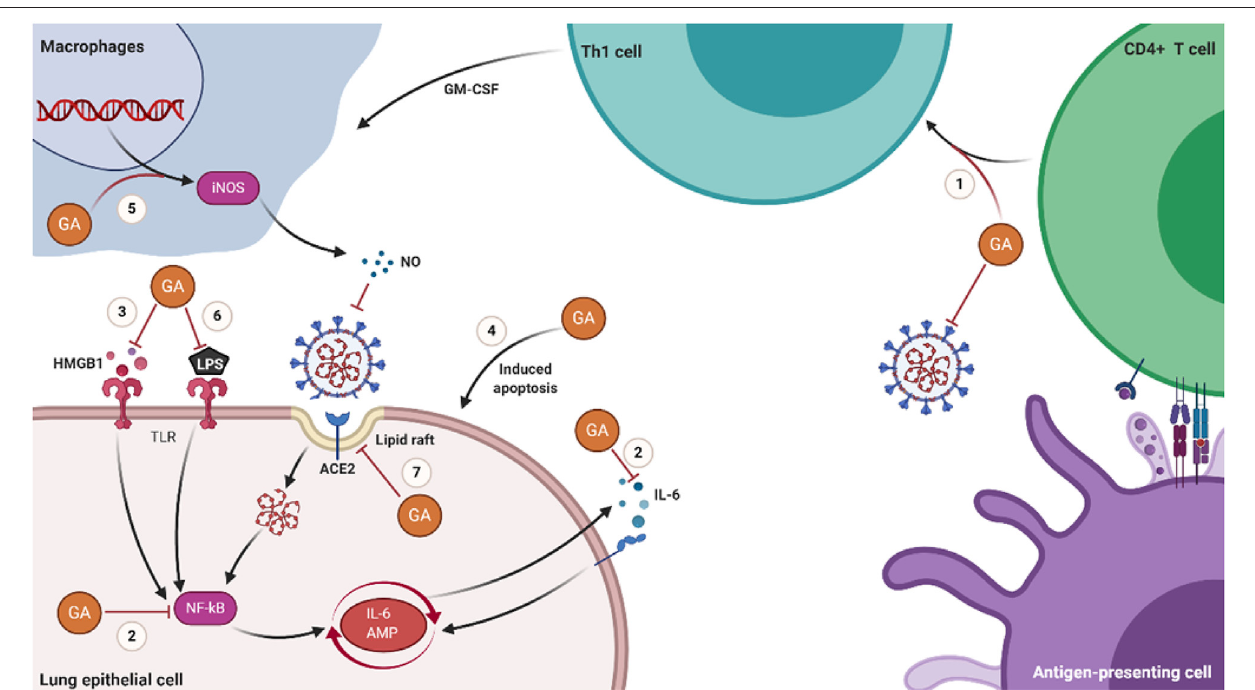
FIGURE 2 | Schematic diagram of the molecular mechanisms of GA in treating COVID-19. (1) GA promotes the proliferation of T cells and has Th1 cell immune adjuvantactivity. (2)GAinhibitsthe production ofIL-6and theactivationofNF- κ B. (3)GAinhibits theactivity ofHMGB1and thesignal transduction oftheHMGB1-TLR4 pathway. (4) GA induces the apoptosis of host cells latent with SARS-CoV-2. (5) GA stimulates macrophages to produce NO. (6) GA inhibits the in fl ammatory response induced by LPS. (7) GA prevents the invasion of SARS-CoV-2 by reducing the domain of lipid rafts.